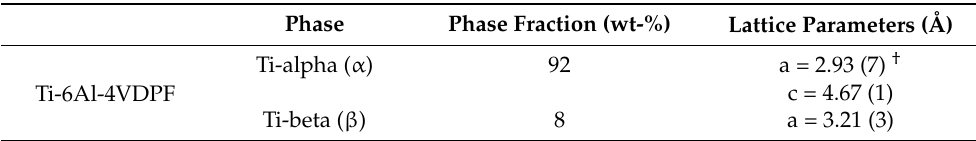
Table 5. Rietveld refinement of Ti-6Al-4V DPF after annealing at 925 °C for 2 h.